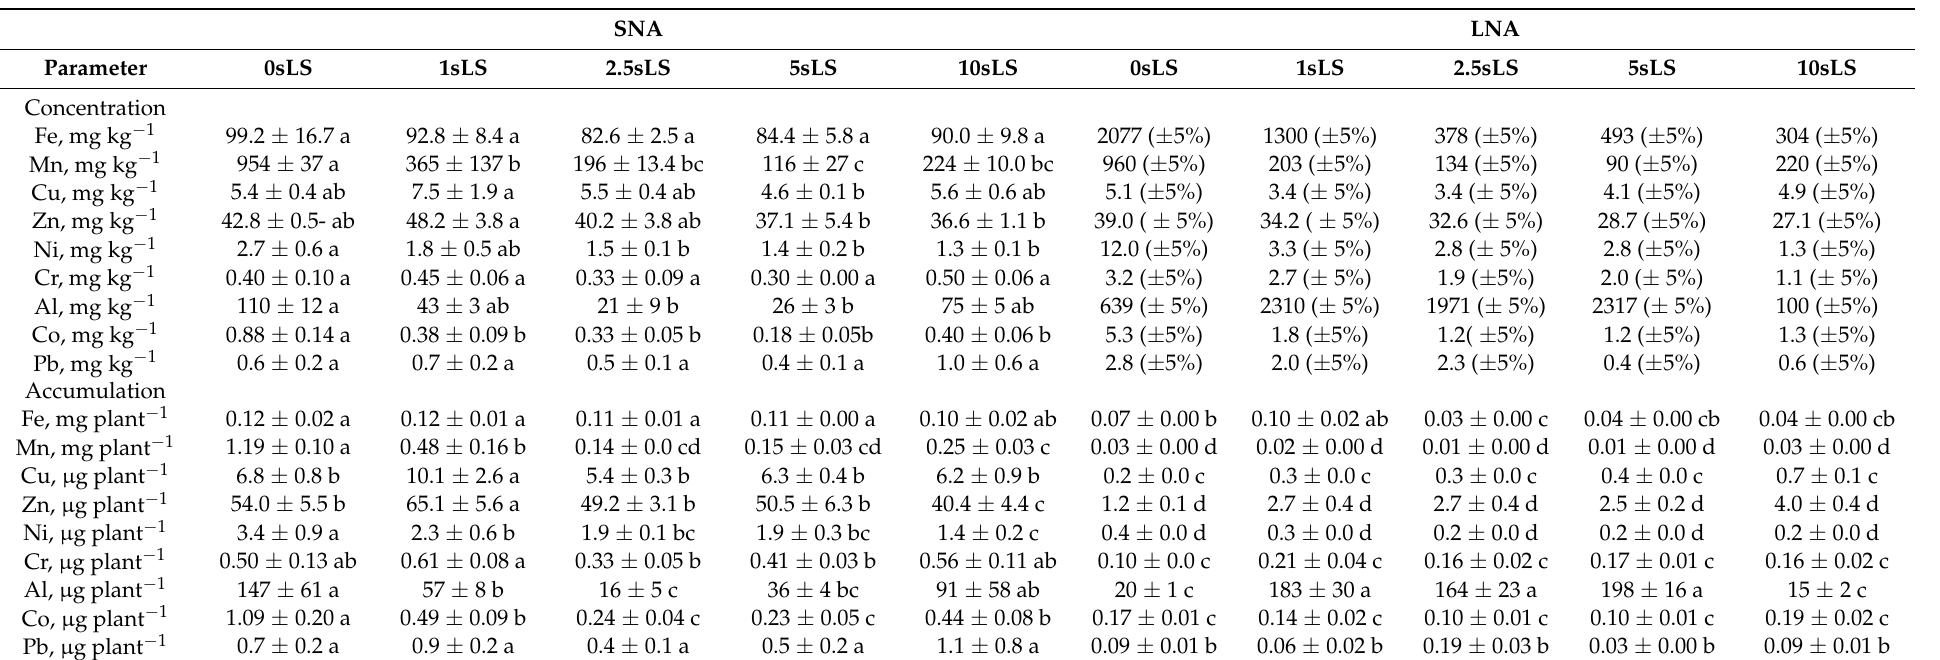
Table 2. Concentration and accumulation of microelements in leaves of cucumber seedlings grown on sandy loam soil with lignosulfonate concentrations of 0